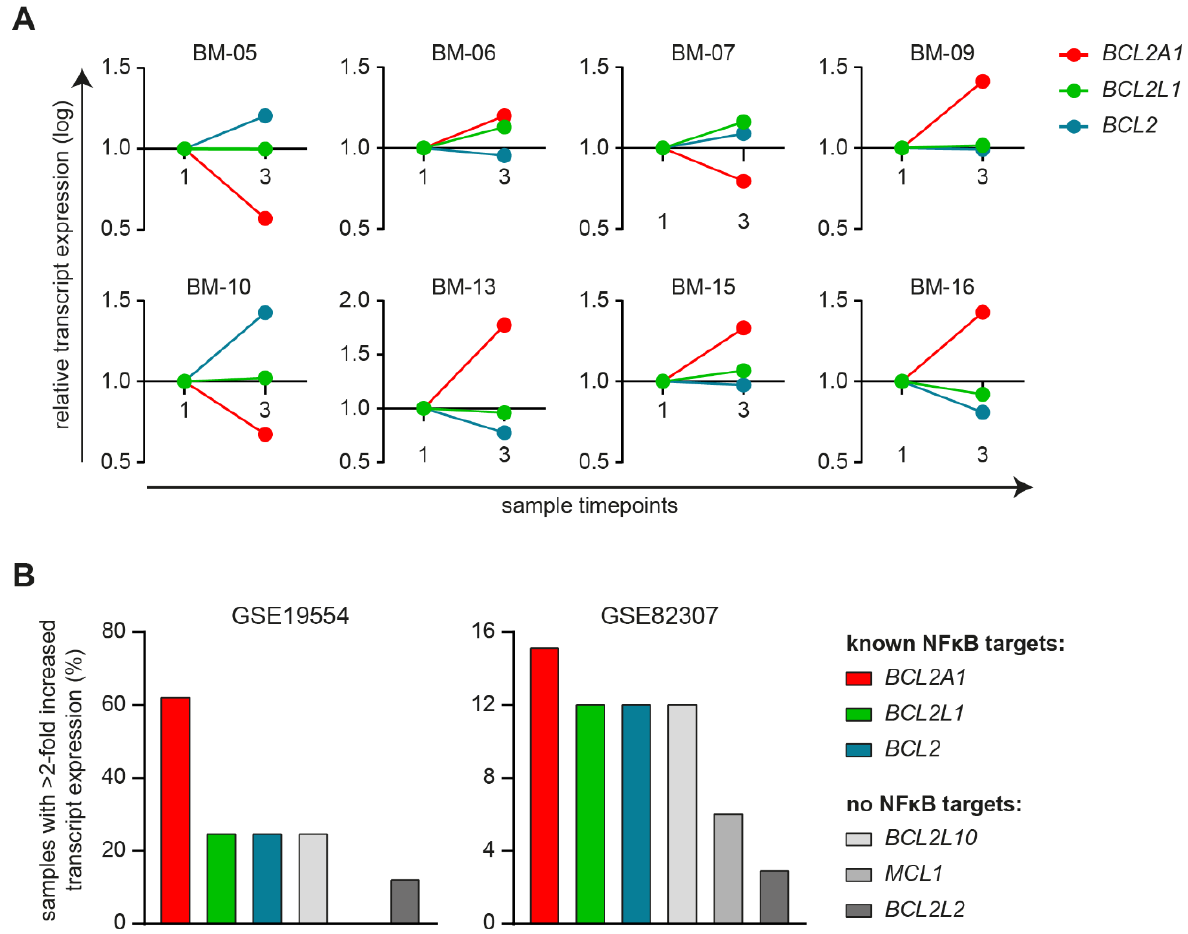
Figure 3. ( A ) Plots showing relative mRNA transcript expression of BCL2A1 (BFL-1), BCL2L1 (BCL-XL), and BCL2 (BCL-2), in PC taken at diagnosis (timepoint 1), and after second-line chemotherapy-based induction therapy after relapse to first-line total therapy (timepoint 3), from 8 individual MM patients, as included in dataset GSE19554. ( B ) Bar graphs showing the percentage of MM PC patient samples that showed >2-fold increased mRNA transcript expression of NF κ B-regulated pro-survival targets BCL2A1 , BCL2L1 , and BCL2 , and NF κ B-independent pro-survival members BCL2L10 (encoding BCL-B), MCL1 (encoding MCL-1), and BCL2L2 (encoding BCL-W), after relapse to first-line total therapy, with (dataset GSE19554) or without (GSE82307) subsequent administration of second-line induction therapy, in comparison to mRNA transcript expression at